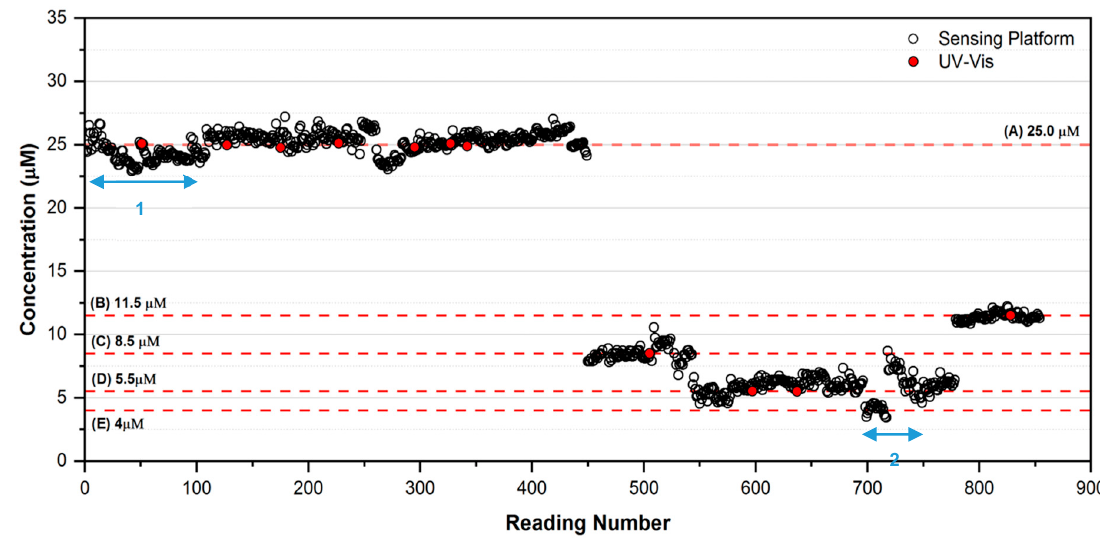
Figure 6. Laboratory analysis of phosphate standards (PO 43 − ) with the autonomous sensing platform (clear dots) and the UV-Vis spectrophotometer reference method (red dots). Performance issues Sections 1 and 2 (blue line). Table 2. Summary of the analytical performance of the sensing platform during laboratory testing. PO 43 − ( µ